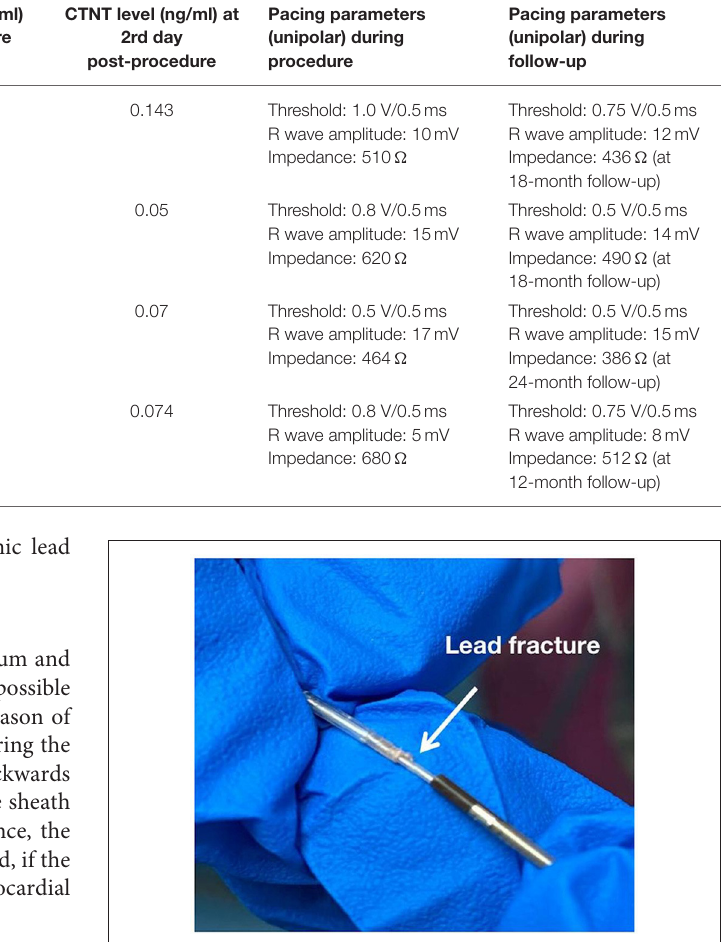
TABLE 3 | Characteristics of four cases with septum injury during procedure. Case No.